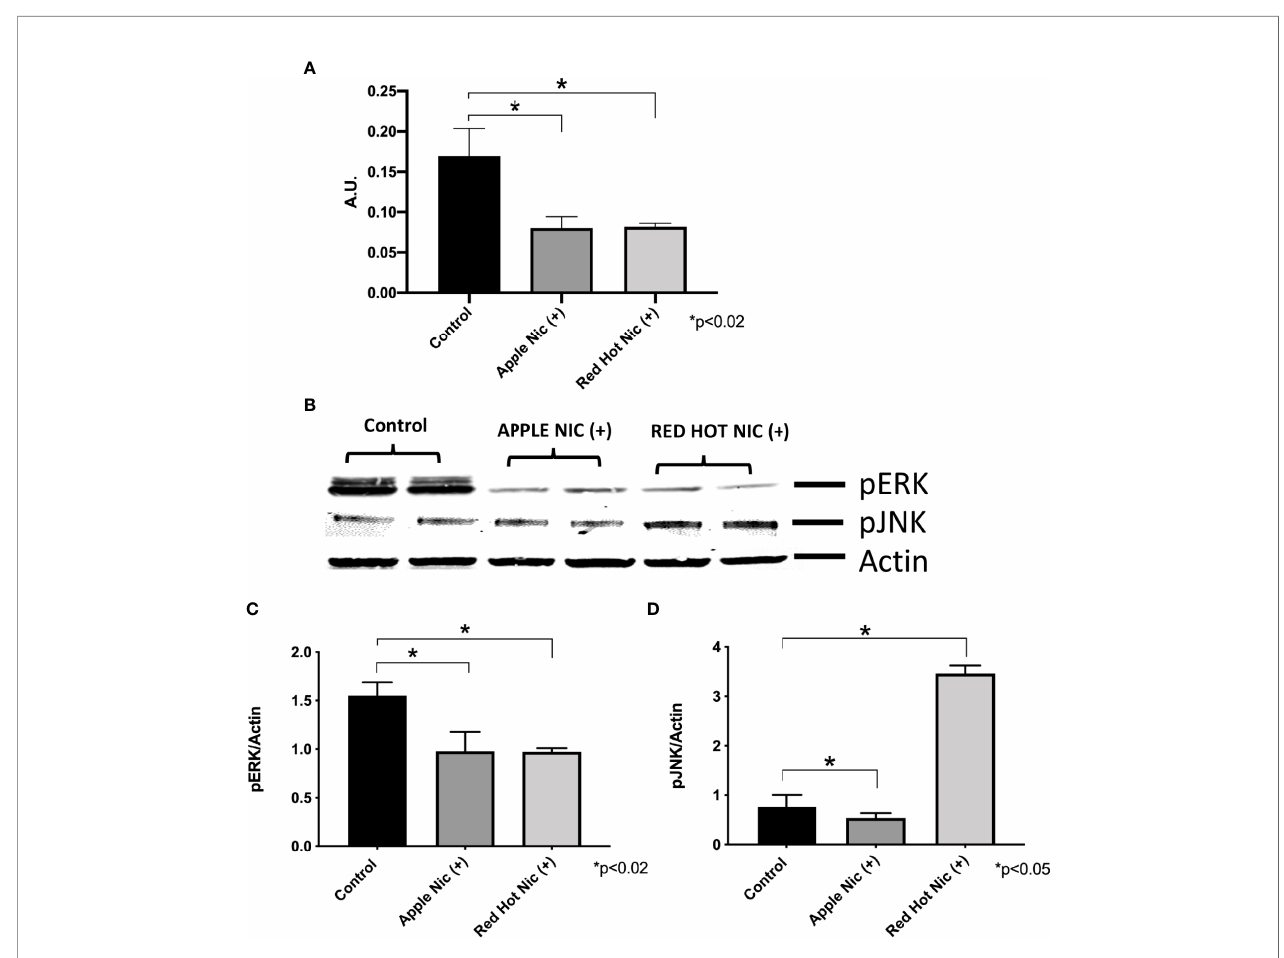
FIGURE 2 | | Expression of NF- k B (A) , pERK (B) , and pJNK (C) in Cal27 cells exposed to EVE. ELISA was performed to determine NF- k B released into the cell medium. ERK and JNK were determine by western blot. Released NF- k B was decreased with both fl avors and nicotine in these cells (A) as compared to media only treated controls cells. A representative western blot results for ERK and JNK is shown in (B) Activation of ERK and JUNK proteins protein was decreased after exposure to both fl avoring with nicotine except for induction of pJNK by Red Hot (C, D) . Data are shown with * p ≤